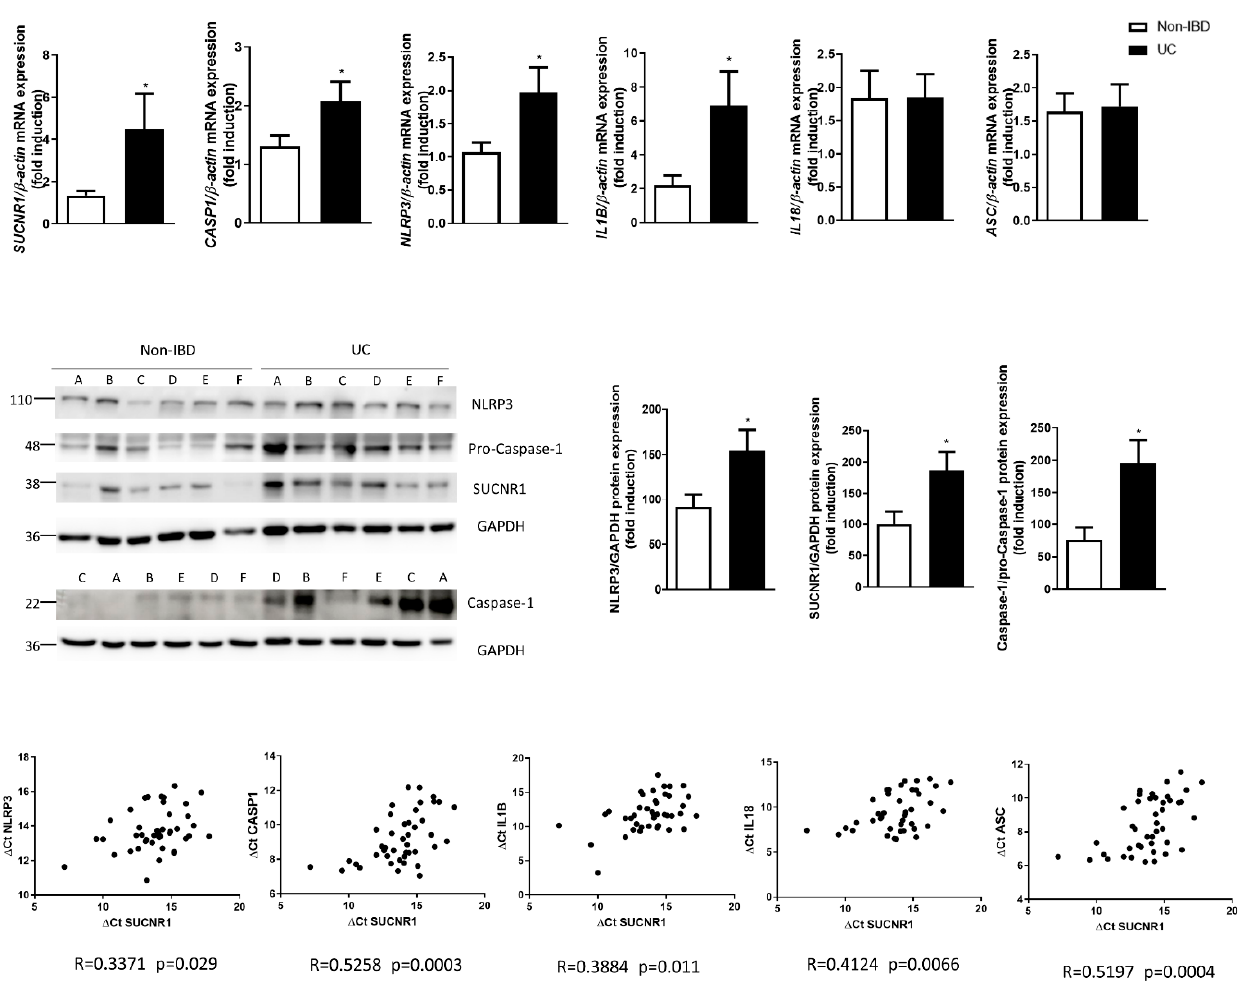
Figure 6. SUCNR1 and inflammasome components are increased and positively correlated in surgical resections from UC patients. ( a ) Graphs show mRNA expression of SUCNR1 , NLPR3 , CASP-1 , IL1B , IL18 and ASC in intestinal resections from UC patients ( n = 25) and non-IBD patients ( n = 30). ( b ) Graphs show protein expression of SUCNR1, NLRP3 and Caspase-1/pro-Caspase-1 ( n = 15). Bars in graphs represent mean ± SEM. * p < 0.05 vs. non-IBD patients. ( c ) Graphs show the correlations between data relative to mRNA expression of SUCNR1 vs. mRNA expression of the inflammasome components NLRP3 , CASP1 , IL1B and IL18 (expressed as Δ Ct). In each correlation, the value of the Spearman’s correlation coefficient (R) and p value are shown.